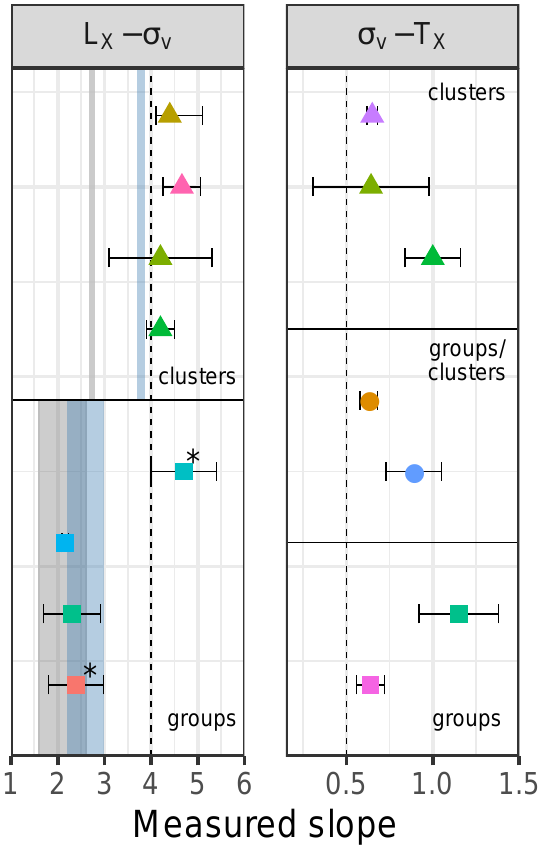
Figure 5. Compilation of the measured slopes of the luminosity-velocity dispersion (L x – σ v , left panel ) and velocity dispersion-temperature ( σ v –T x , right panel ) relation in the literature. In each case, the dashed vertical line highlights the usual self-similar expectation on the slope for each relation (Equation (8), left panel , and Equation (9), right panel ). The horizontal lines represent a dividing line between the mass scales used for the comparison in each relation. As shown in + 2 γ Section 3.1 when the L x – σ v scaling can be given as L x ∝ σ 3 v (with γ dependent on the energy band and emissivity). The blue shaded region represents the self-similar expectation when considering [ 3.7:3.9 ] bolometric luminosities for clusters (assuming T x = 3.0–10.0 keV, L x ∝ σ v ) and groups (assuming [ 2.2:3.0 ] T x = 0.7–3.0 keV, L x ∝ σ v ). The grey shaded region represents the self-similar expectation